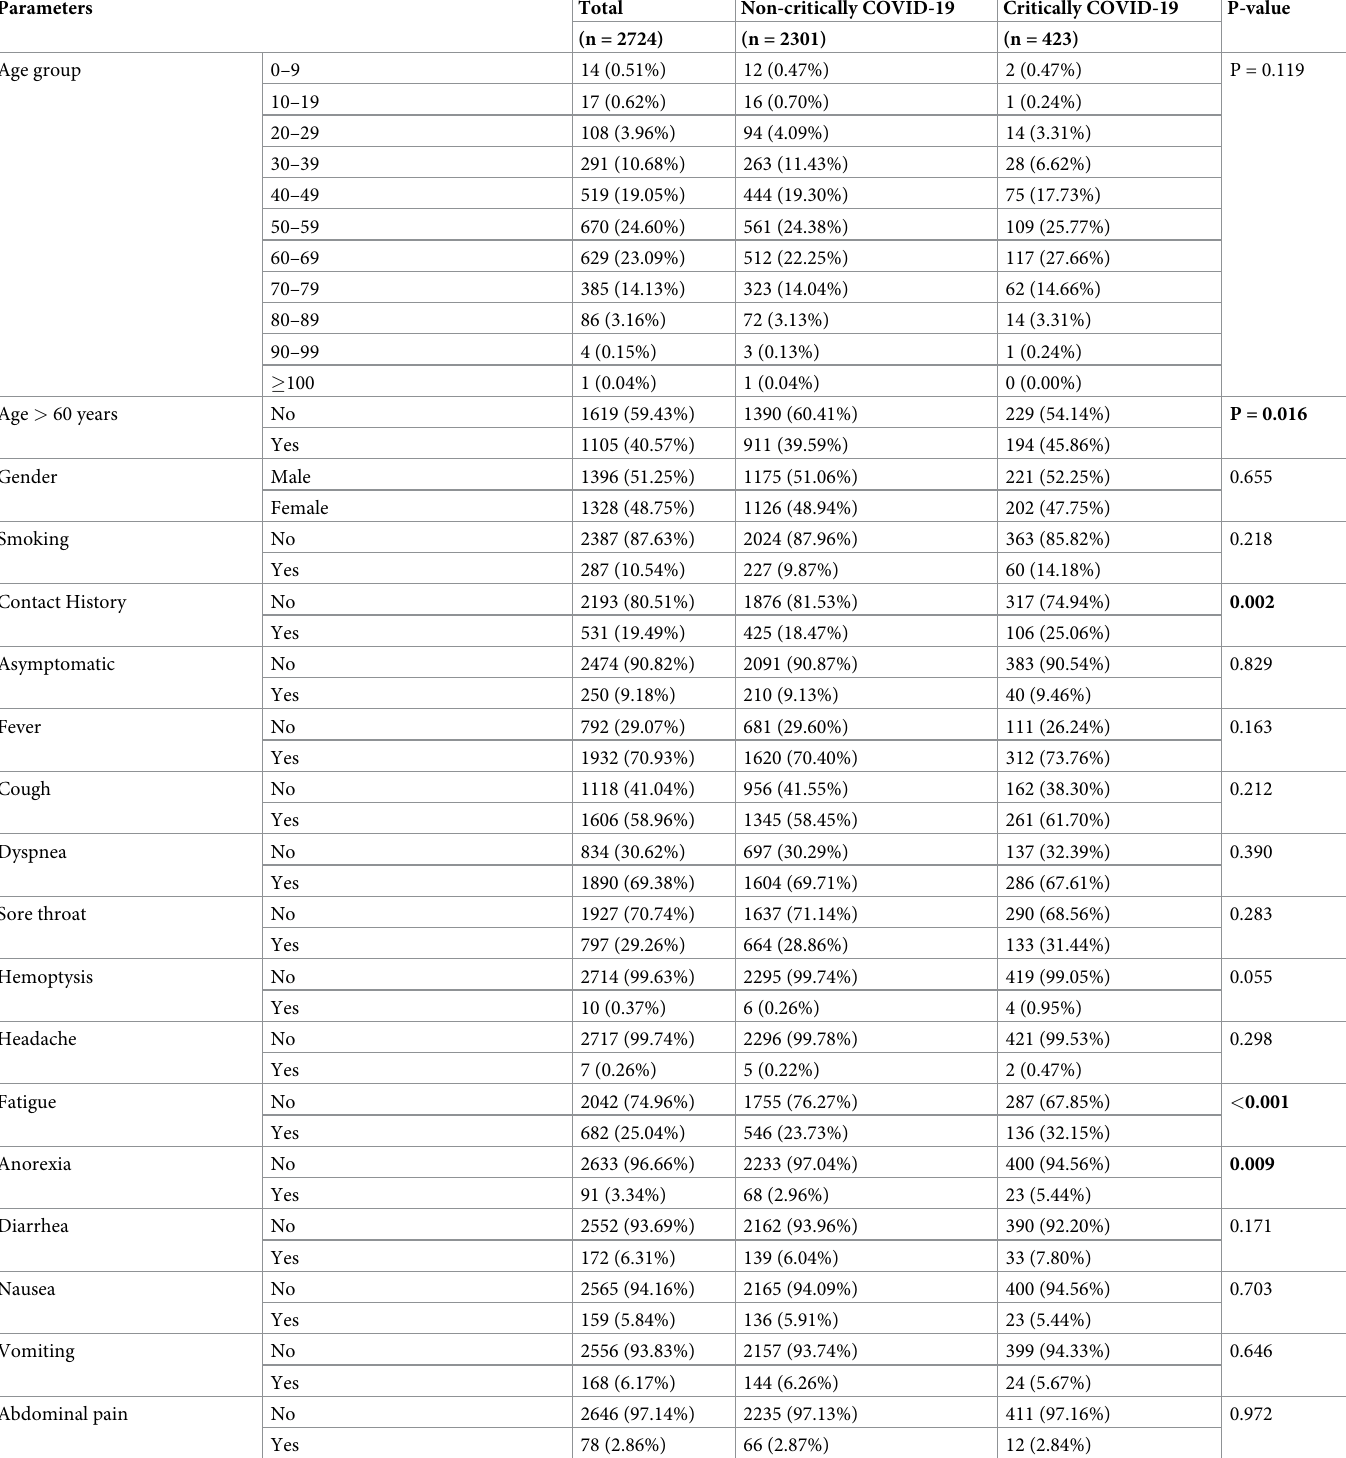
Table 1. Demographic, clinical, and radiological characteristics of included